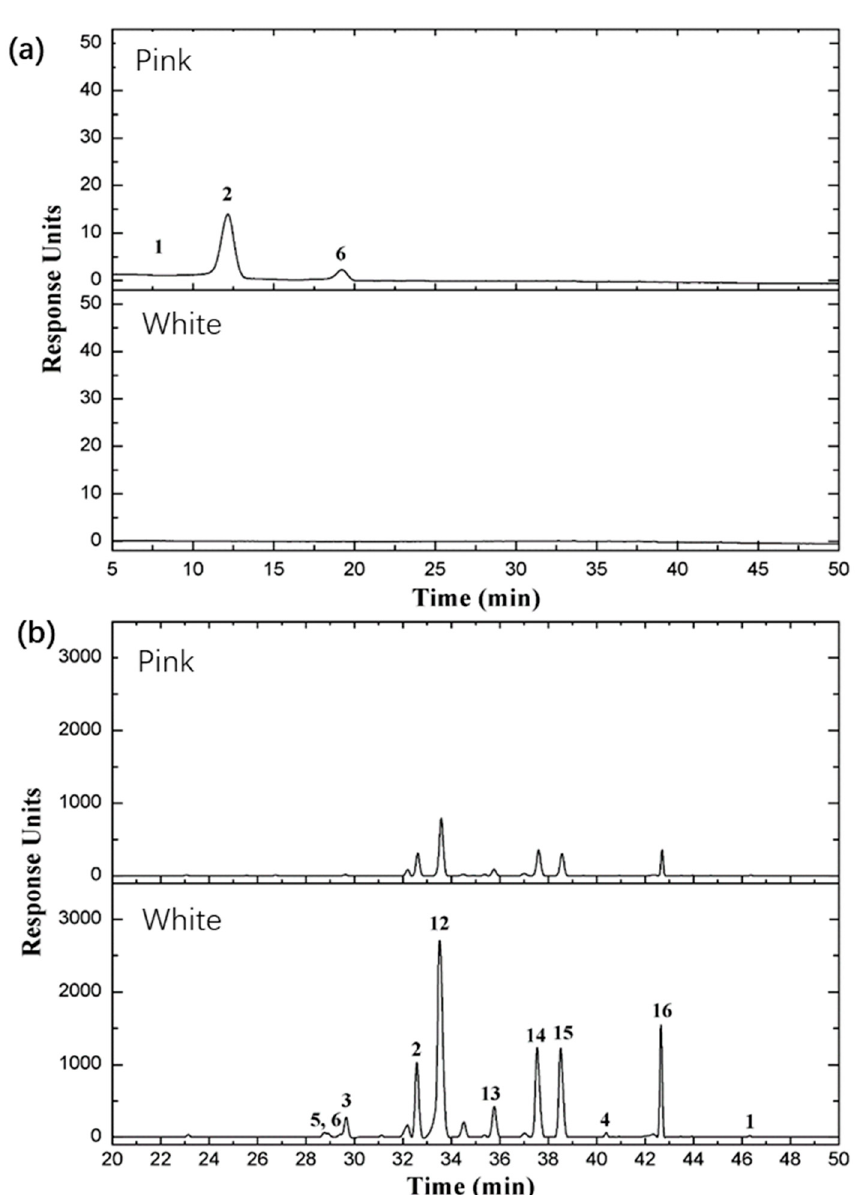
Figure 5. Comparison of ( a ) anthocyanin, and ( b ) flavonoid composition between Rosa ‘Margo Koster’ (pink) and Rosa ‘White Margo Koster’. The horizontal axis represents retention time, the vertical axis represents response units, and numbers on the peaks represent different compositions of anthocyanin and flavonoid. ( a ) 1-cyanidin 3,5-diglucoside, 2-pelargonidin 3,5-diglucoside, 6-pelargonidin 3- glucoside; ( b ) 2-kaempfeol-3-rutinoside, 12-kaempferol-3-glucoside, 13-kaempferol-3- O - α - D - arabinoside, 14-kaempferol-3- O - β -glucopyranosyl-7- O - α -rhamnopyranoside, 15-kaempferol-3- rhamnopyranoside (afzelin), and 16-multiflorin A.